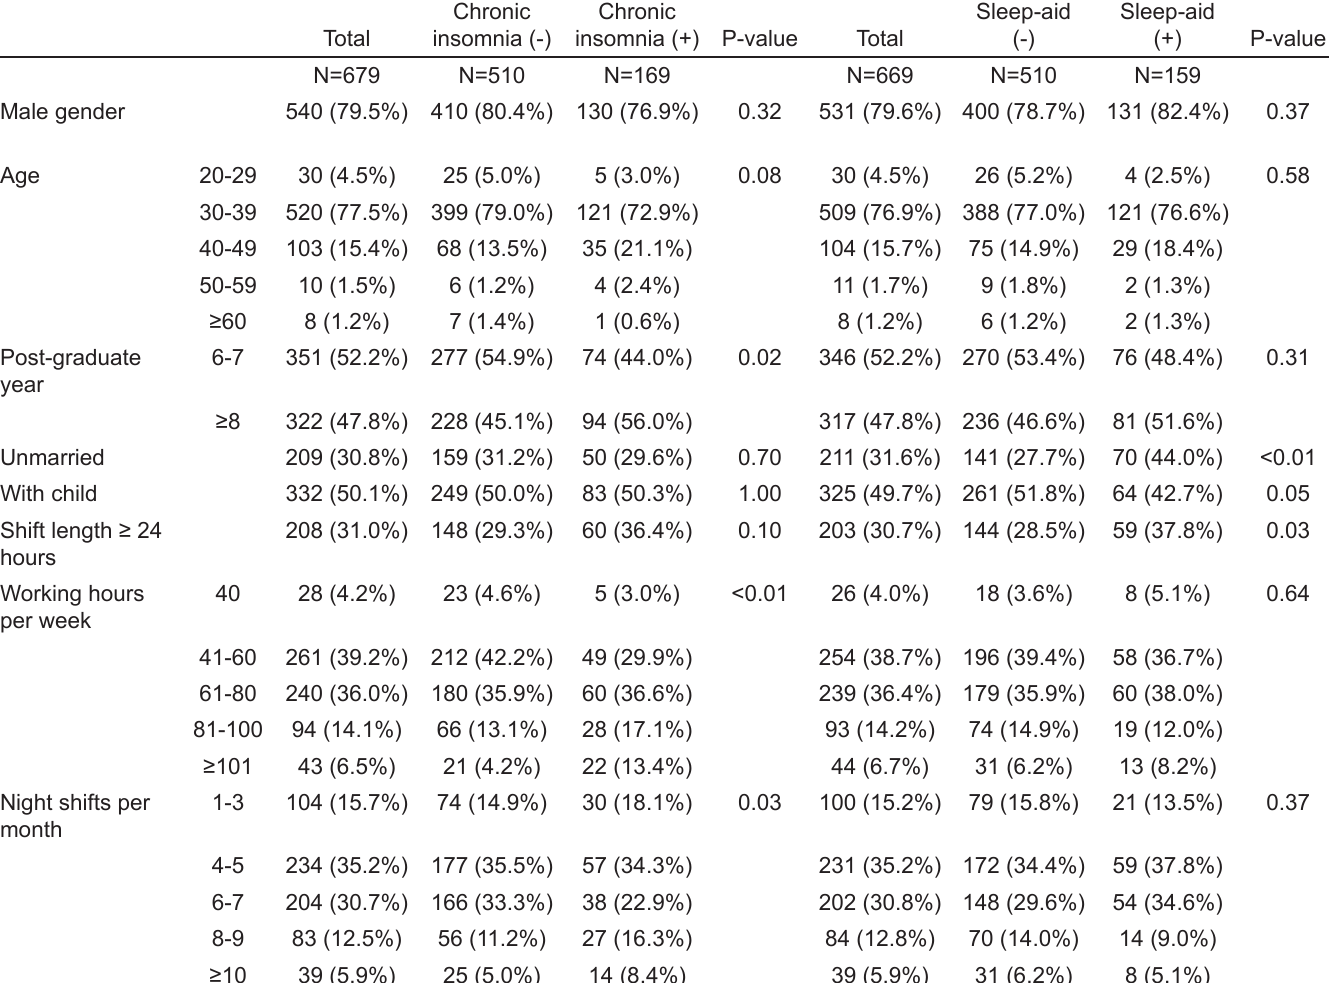
Table 2. Participants’ characteristics.